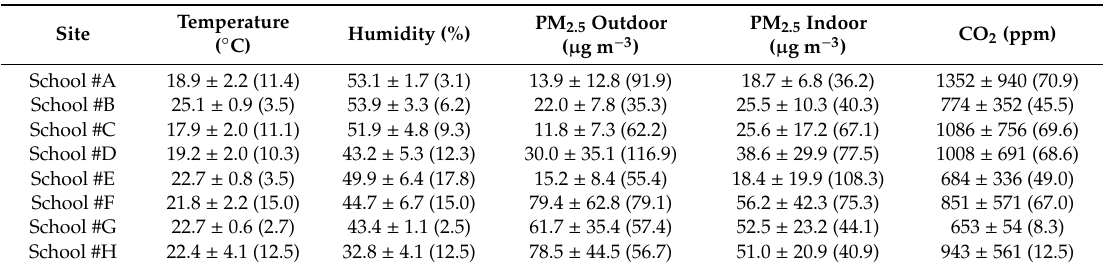
Table 1. Average daily levels of some physical-chemical parameters along with standard deviation (x + s.d.) and coe ffi cient of variation (cv% 1 ) simultaneously determined during the entire measurement campaign in eight schools in downtown Rome.